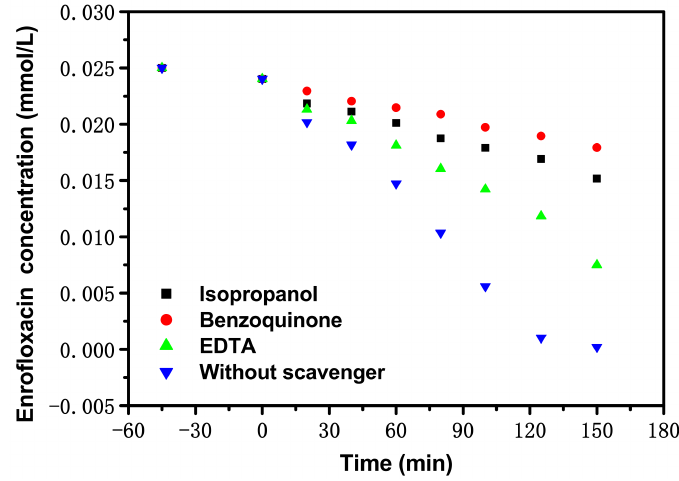
Figure 17. Effect of different radical scavengers such as benzoquinone (BQ), isopropanol (IPA) or ethylenediamine tetraacetic acid (EDTA) on removal efficiency of ENR with EBH as photocatalyst under VLGI.